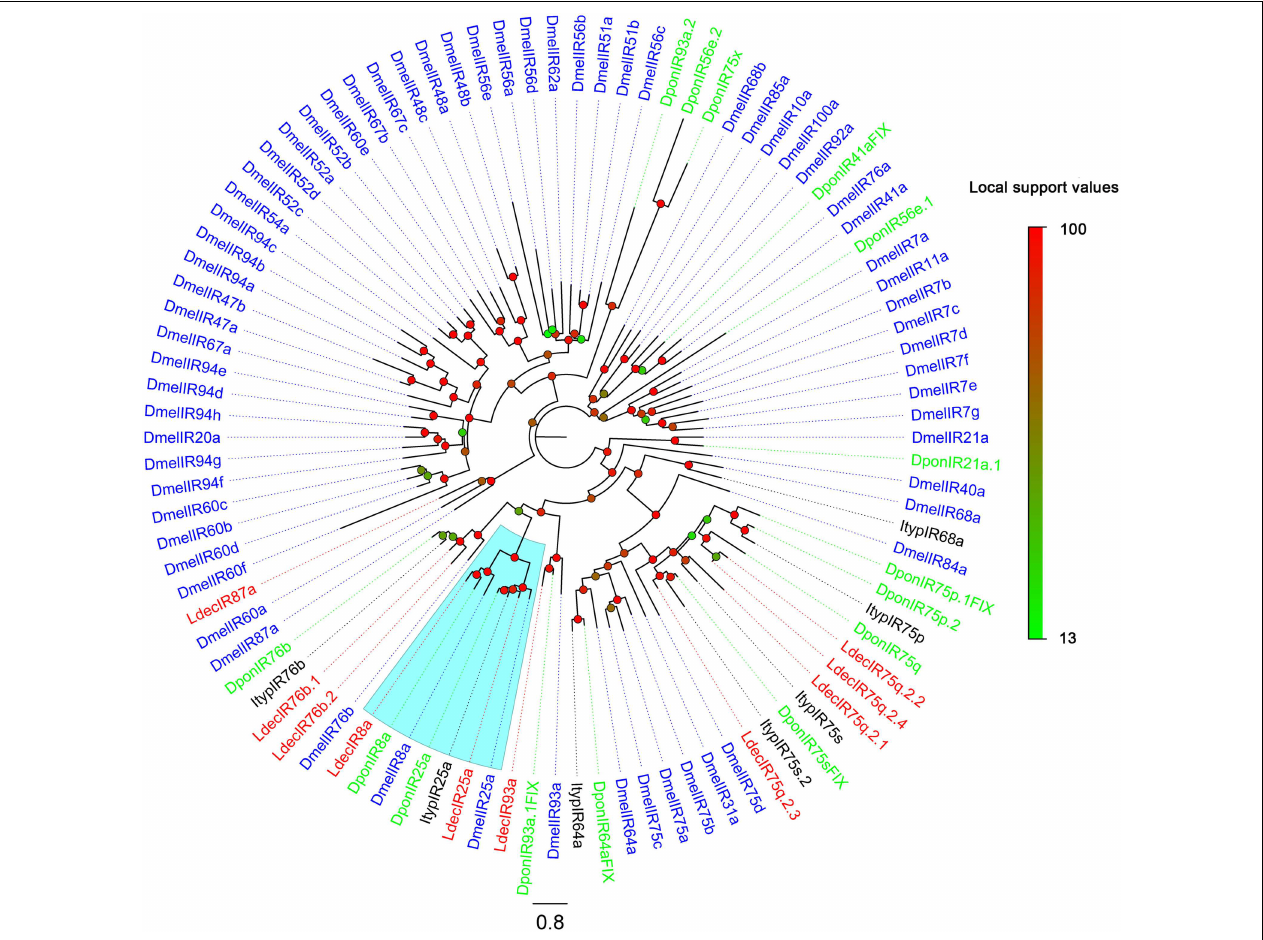
FIGURE 6 | Phylogenetic tree of candidate LdecIRs with IRs from other insects. Dpon, D. ponderosae ; Ityp, I. typographus ; Dmel , D. melanogaster . The clade in blue indicates the IR8a/IR25a clade.